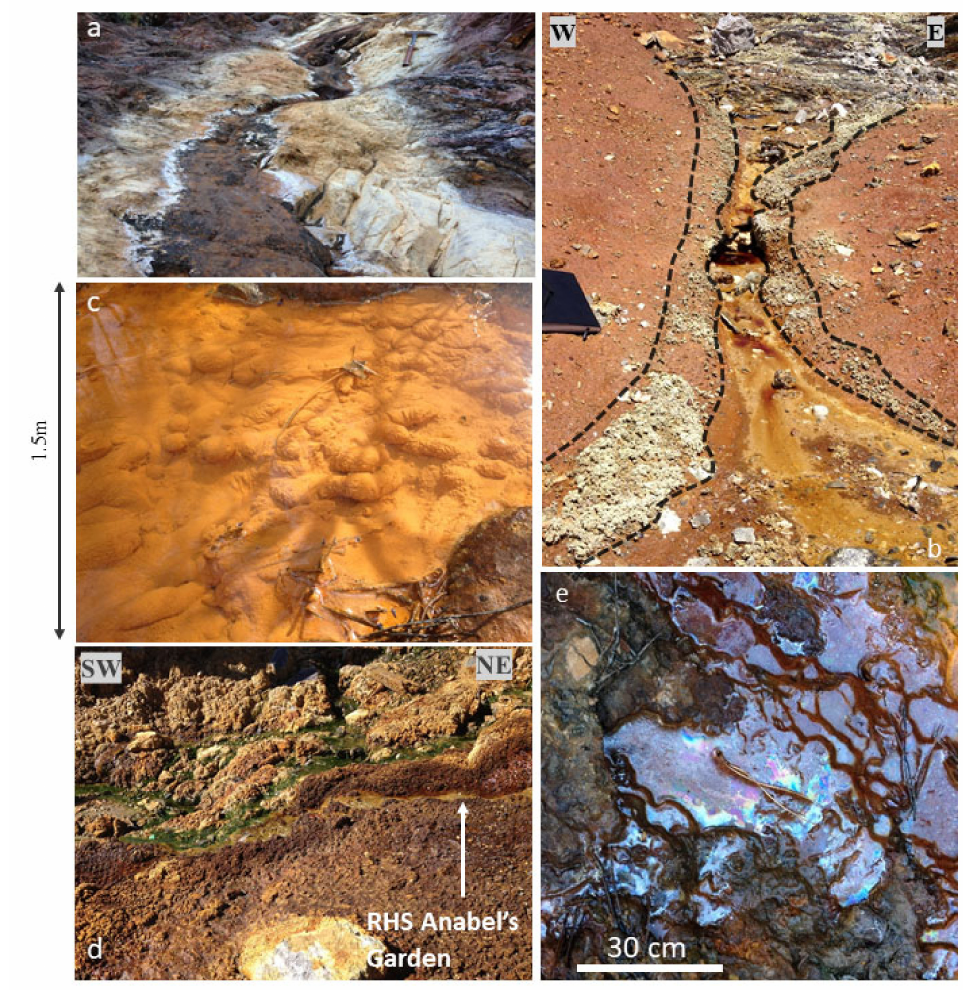
Figure 8. Mineral precipitates in the different spring locations. ( a ) Evaporative precipitates of copiapite and jarosite in a banding orientation on a tributary above Cave Spring; ( b ) Evaporative bands of copiapite on Left Richi spring as a result of intense evaporation and capillary action; ( c ) Nanophase ferrihydrite iron oxyhydroxides precipitates in the Right Spring, reflecting a higher pH; ( d ) Expansive Gypsum deposits on the RHS Anabel’s Garden Spring, with the main channel containing a large percentage of green algae; ( e ) Oily film solution within gypsum deposits suggesting organic degradation of leaves and release of non-polar immiscible organic compounds like large fatty acids and